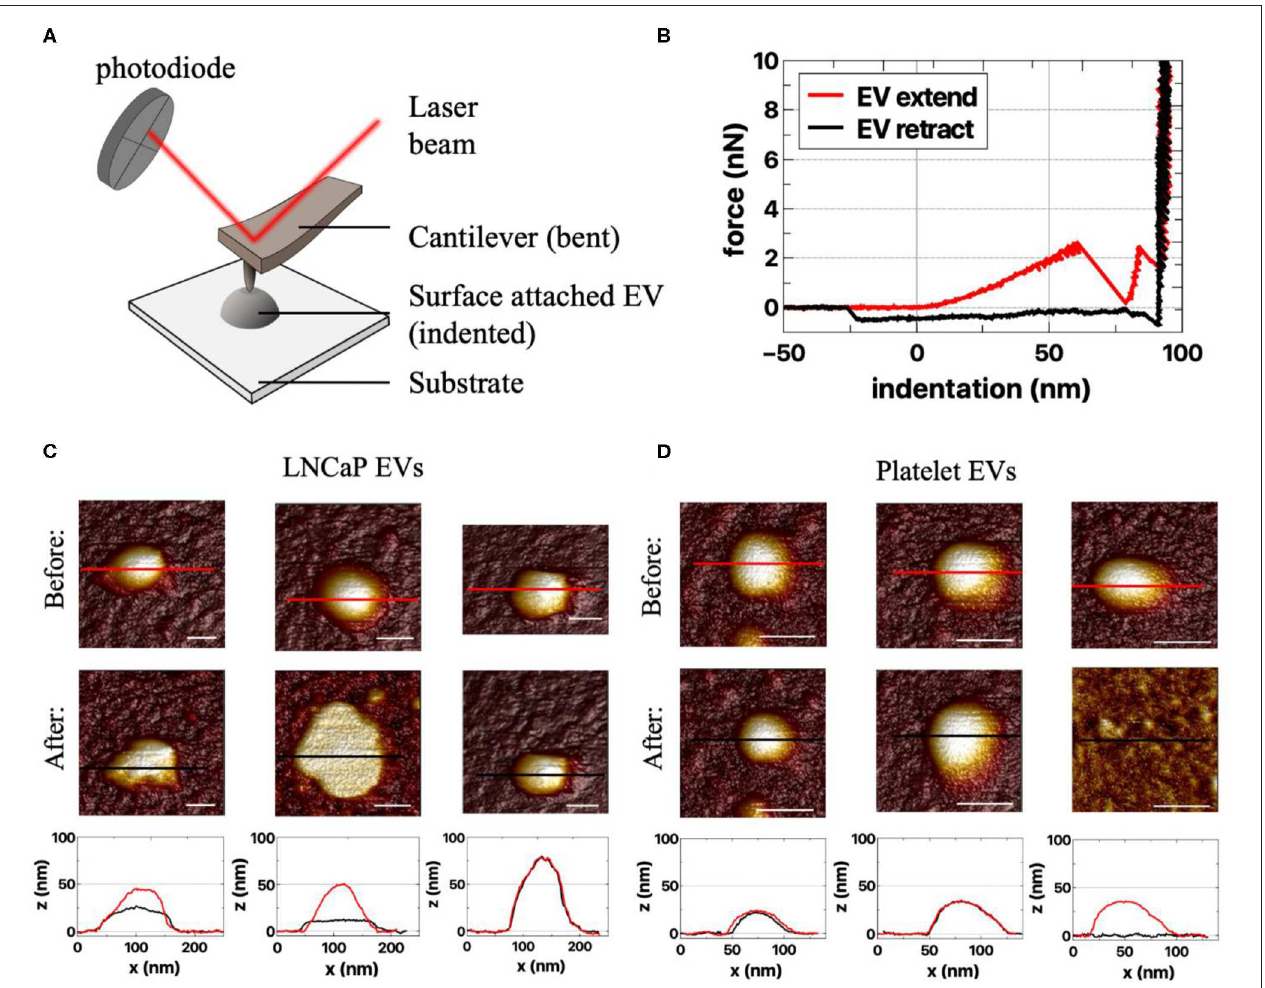
FIGURE 5 | Atomic force microscopy (AFM) of extracellular vesicle (EV) samples. (A) Schematic representation of the AFM setup. In AFM, a cantilever interacts with the sample, and the reflected laser beam is detected by a photodiode (45). The experiments are performed in liquid (not depicted). (B) Example of force–indentation curves (distance z ) of the extend and retract response on an EV ( 45). AFM images of responses of (C) LNCaP EVs and (D) platelet EVs to an applied force before (first row) and after indentation (second row). Both the LNCaP and the platelet EVs can change shape upon indentation. The different responses are illustrated by the cross-sections (bottom row), taken at the indicated spots in the corresponding AFM images above (red, before indentation; black, after indentation). Scale bars represent